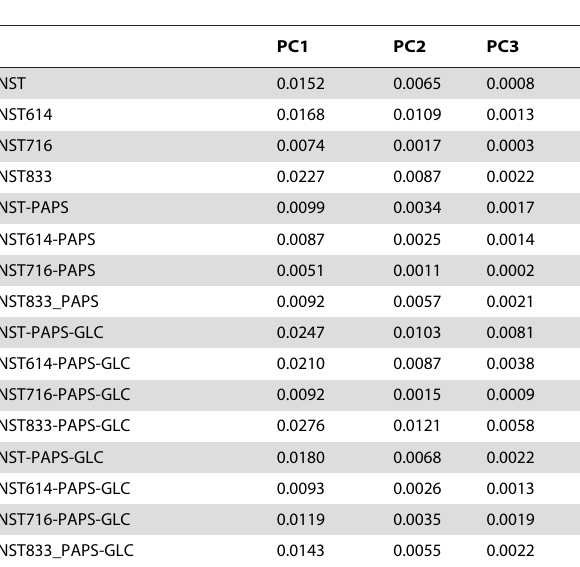
Table 2. Cosine Content of the First Three